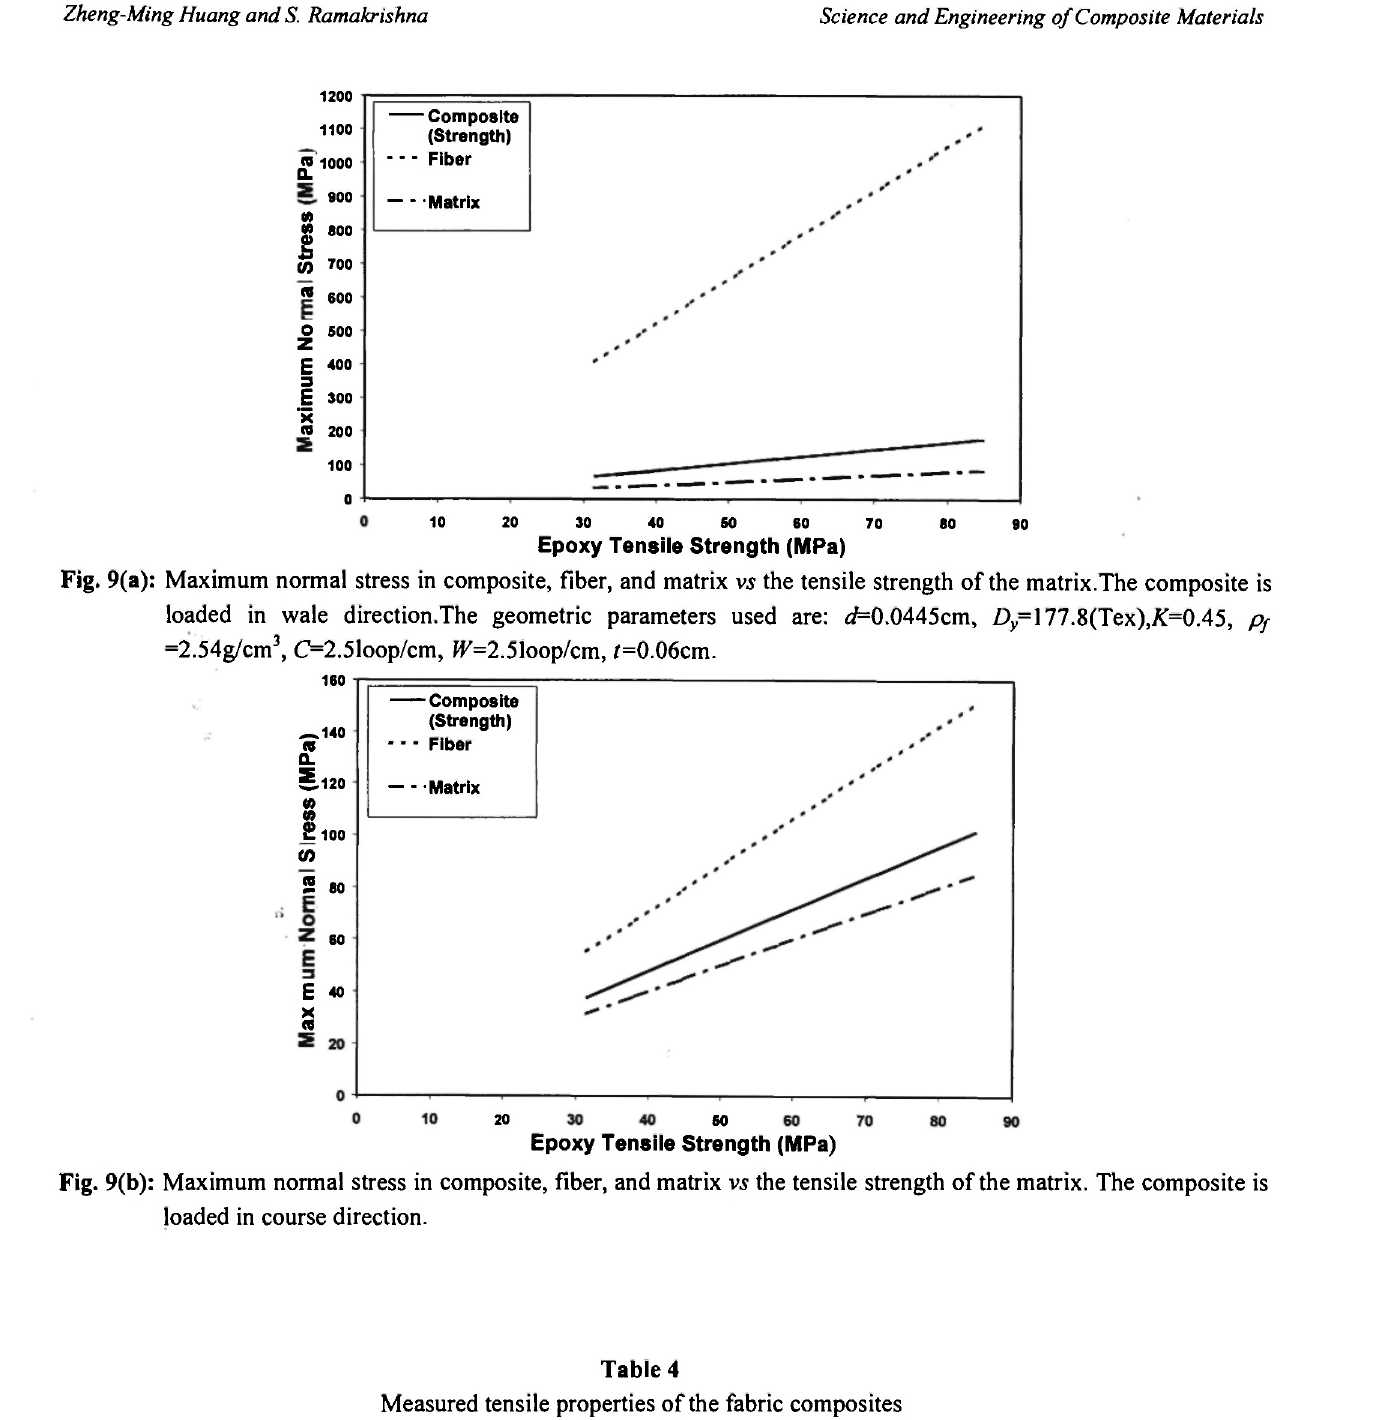
Fig. 9(b): Maximum normal stress in composite, fiber, and matrix vs the tensile strength of the matrix. The composite is loaded in course